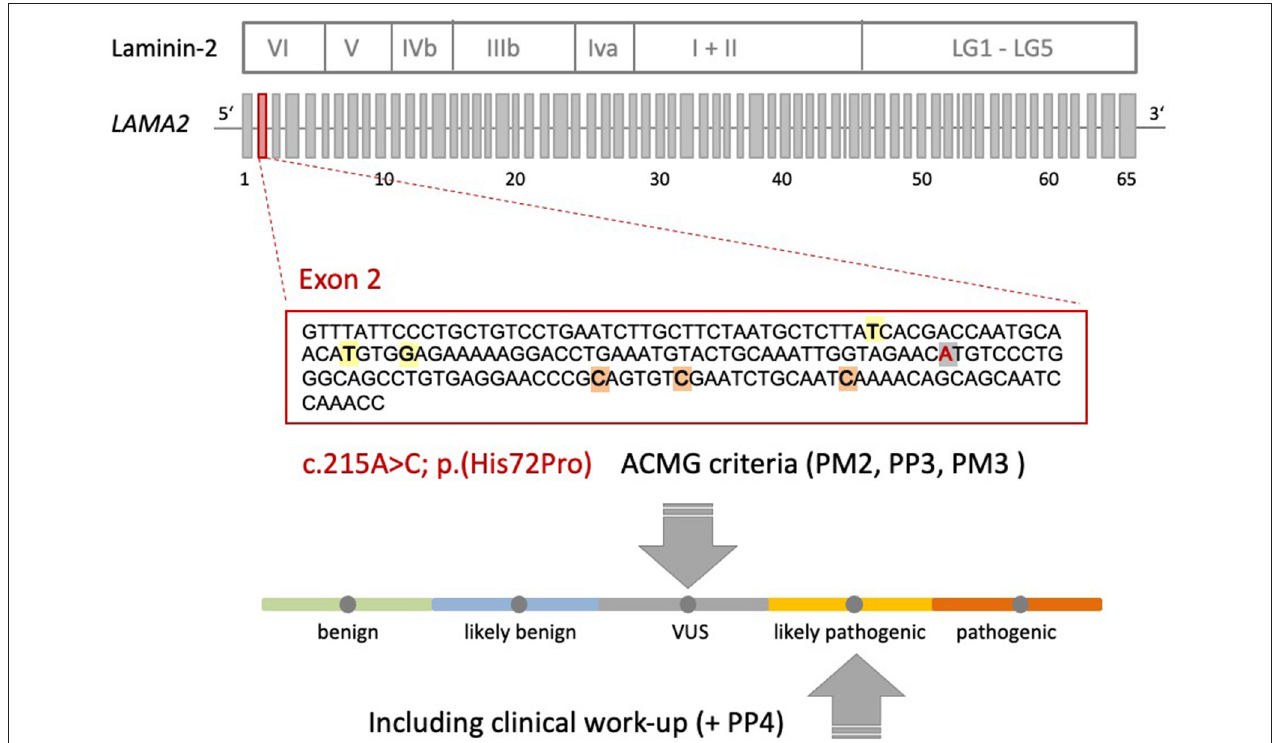
FIGURE 1 | Schematic representation of the Laminin-2 protein, the gene architecture of LAMA2 and the VUS c.215A > C (p.(His72Pro)) detected in our patient. LAMA2 consists of 65 exons. According to HGMD ® Professional 2021.4, three pathogenic non-sense variants and three missense variants with uncertain significance are described in exon 2 of LAMA2 in the context of muscular dystrophy. Orange: non-sense variants: c.244C > T (p.Q82*), c.250C > T (p.R84*), c.283C > T (p.Q95*); yellow: missense variants: c.155T > A (p.I52N), c.172T > C (p.C58R), c.176G > A (p.G59E); gray: VUS c.215A > C (p.His72Pro) detected in our patient. The ACMG criteria leading to the initial classification “VUS” are shown. Additional clinical work-up (e.g., MRI scan) revealed a clinical phenotype and MRI pattern consistent with LGMDR23. Therefore, the VUS could be re-classified as likely pathogenic ( + PP4).